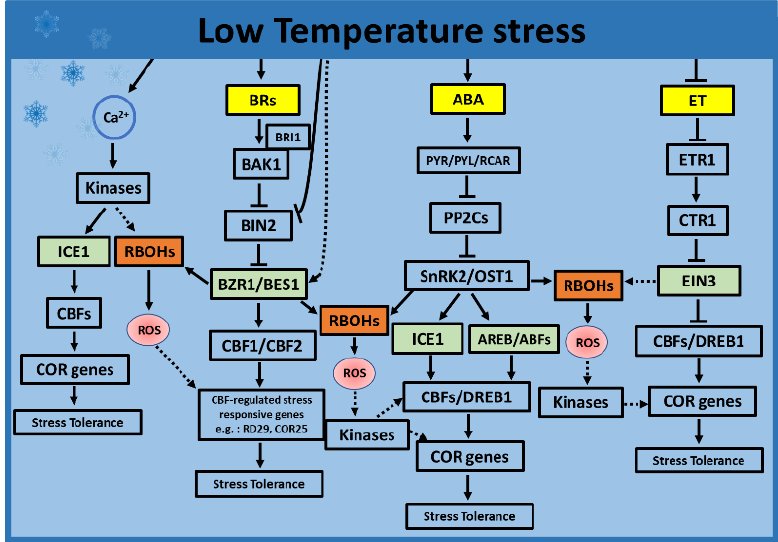
Figure 3. Selected hormone and ROS interactions in response to low-temperature stress. During low temperatures, ABA-regulated kinase SnRK2 regulates the stability and transcriptional activity of ICE1, causing the activation of CBF/COR. Parallelly, SnRK2 could phosphorylate RBOHs, generating ROS. Similarly, TFs BZR1 and EIN3 possibly induce RBOHs to generate ROS via the BR and ET-signaling pathways, respectively. The ROS generated in a feedback loop could induce the expression of CBFs via kinases. Alternatively, low temperatures cause membrane rigidification, which might induce a calcium signature that activates kinases. The activated kinases could phosphorylate ICE1 or RBOHs, thus inducing the expression of COR genes to orchestrate the appropriate molecular and physiological acclimation responses to low temperatures. Other plant hormones such as JA and SA may also play roles in inducing the stress responses to low temperatures. Only ABA, BRs, and ET were selected to be presented in the mode due to the availability of a relatively large amount of data supporting their roles in ROS interactions in response to low-temperature stress. Solid arrows and blocked arrows indicate confirmed positive and negative regulations. Dashed lines indicate potential interactions. The hormones are indicated in yellow, transcription factors in green, ROS in red, and the ROS- producing and -scavenging enzymes are indicated in brown and blue, respectively. ABA, abscisic acid; AREB/ABF, ABA-responsive element-binding protein/ABA-binding factor; BR, brassinos- teroid; BAK1, BRI1-ASSOCIATED KINASE1; BES1, BRI1-EMS SUPPRESSOR1; BIN2, brassinosteroid insensitive 2; BRI1, BRASSINOSTEROID INSENSITIVE1; BZR1, BRASSINAZOLE-RESISTANT1; Ca 2+ , calcium; CBF, C-repeat-binding factor; COR , cold-response genes; CTR1, CONSTITUTIVE TRIPLE RESPONSE1; DREB1, dehydration response element binding factor1; ET, ethylene; EIN3, ETHYLENE INSENSITIVE3; ETR1, ethylene receptors; ICE1, inducer of CBF expression 1; OST1, OPEN STOMATA 1; PP2C, protein phosphatase 2Cs; PYR/PYL/RCAR, pyrabactin resistance protein or PYR-like proteins; RBOHs, respiratory burst oxidase homologs; ROS, reactive oxygen species; and SnRK2, SNF1-related protein kinase